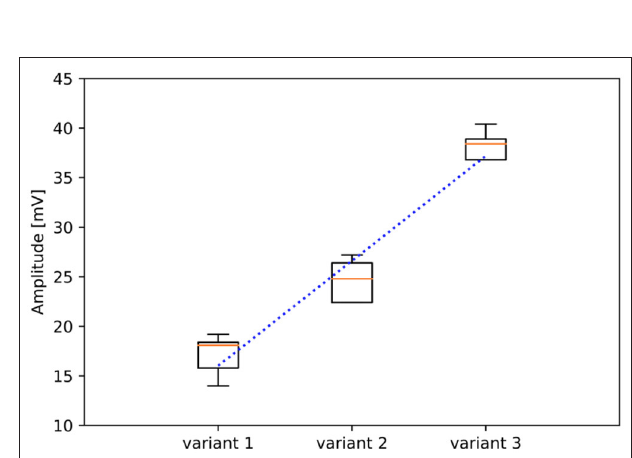
FIGURE 7 | Averaged values (AVG) which had been measured before (blue dash-dot line) and after (green dash line) the metallization of the test substrate. The average shrinkage ratios of the different feed rates are represented as red dots, whereas the linear regression of the shrinkage ratio is represented by the red line. The shrinkage ratio decreases with higher feed rates. Note that the linewidth axis starts at 500 µ m and the shrinkage ratio axis starts at 0.6. The arrows present the affiliation of the graphs to the axes.